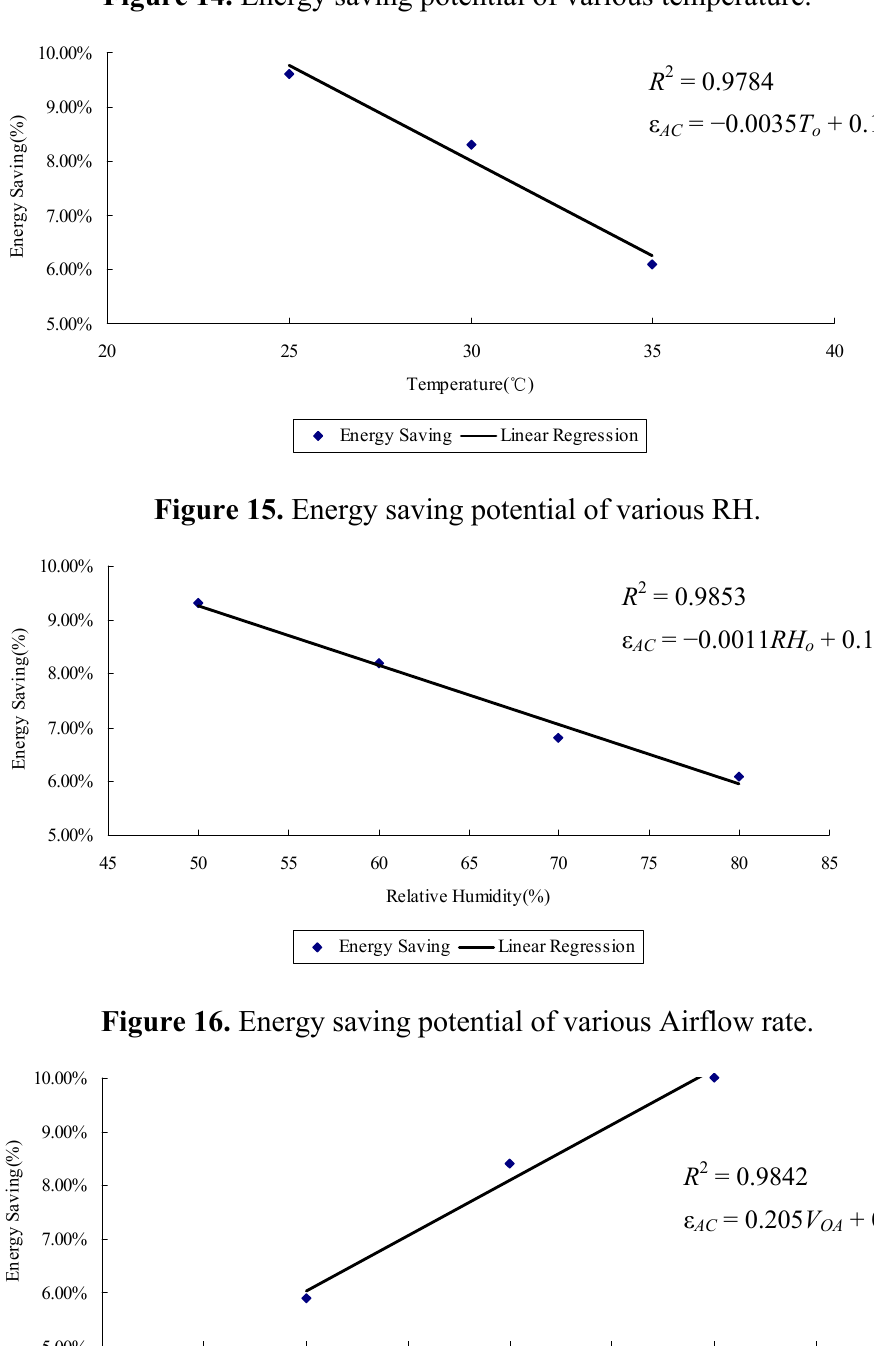
Figure 14. Energy saving potential of various temperature.